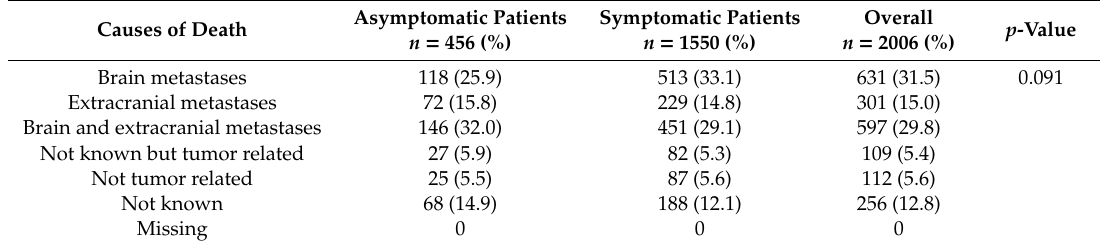
Table 5. Causes of death in patients with asymptomatic and symptomatic